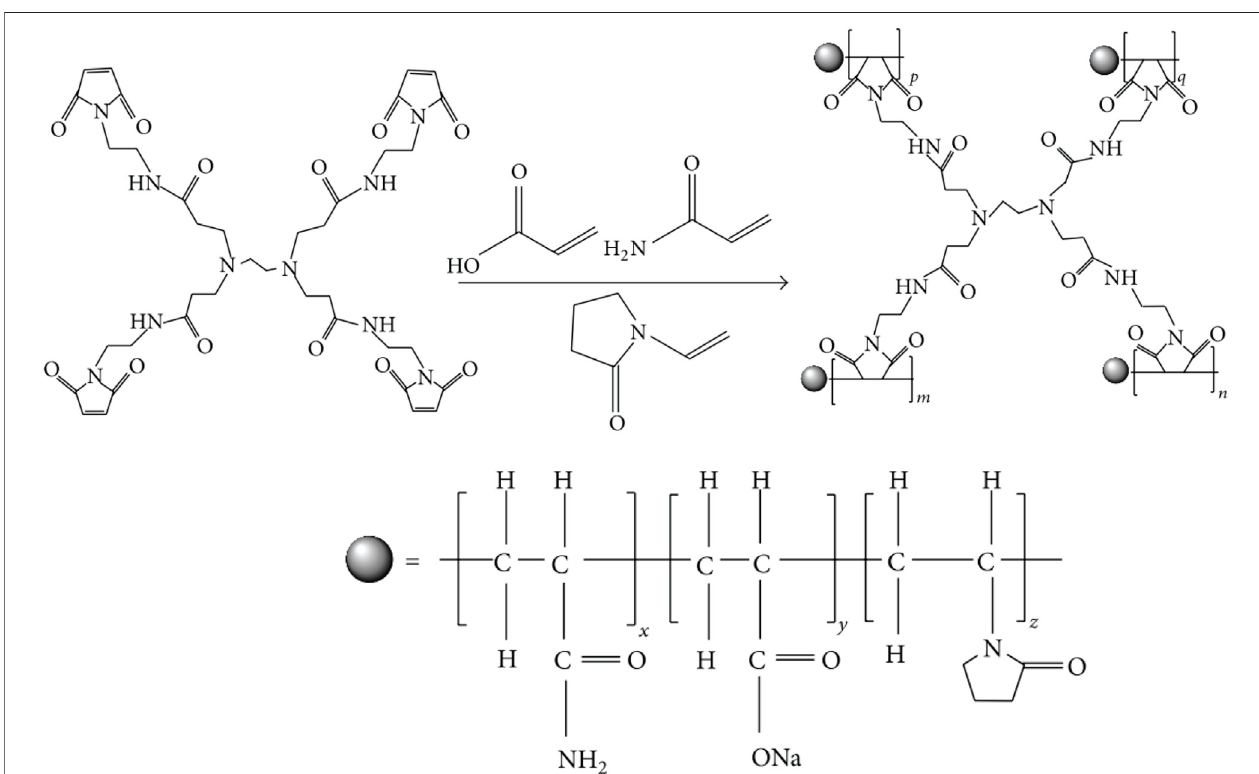
FIGURE 11 | Synthesis route of the hyperbranched polymer as an oil displacement agent (Lai et al., 2013).